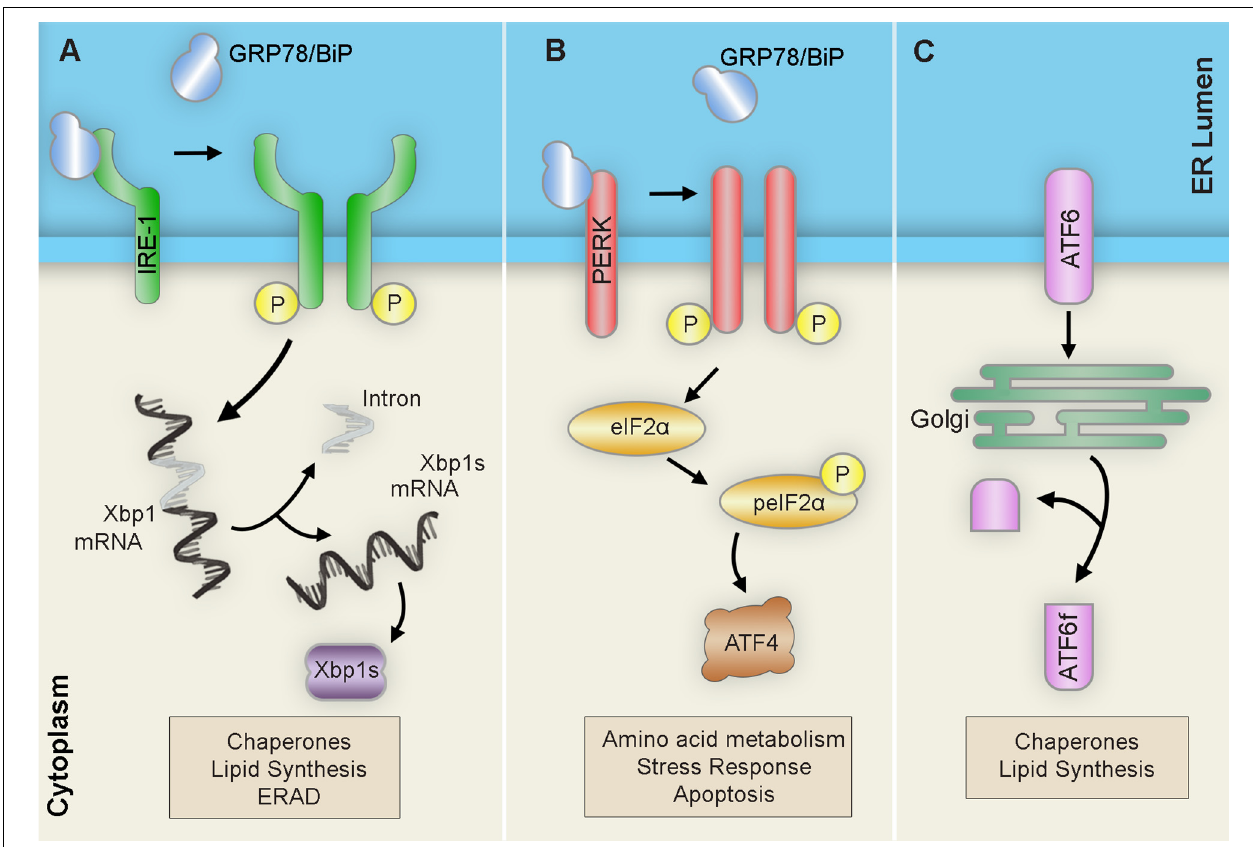
FIGURE 2 | Unfolded protein response (UPR) pathways. Upon ER stress, the ER launches three pathways collectively known as the unfolded protein response (UPR) in an attempt to restore proteostasis: (A) IRE1 homodimerizes and autophosphorylates to promote the alternative splicing of Xbp1 mRNA into the Xbp1 spliced form (Xbp1s) transcript. After translation, the resulting Xbp1s transcription factor translocates to the nucleus of the cell to activate ER chaperones, ERAD components, and lipid biosynthesis factors. (B) PERK homodimerizes and autophosphorylates to induce eIF-2 α phosphorylation ultimately leading to the upregulation of the transcription factor ATF4. This will result in subsequent upregulation of amino acid metabolism, stress response, and apoptosis. (C) ATF6 translocates to the Golgi where it is cleaved into its active form ATF6f and then moves to the nucleus to trigger the expression of ER chaperones, XBP-1, CHOP, and members of the ER-associated degradation (ERAD) pathway. Abbreviations: ATF, activating transcription factor; ATF6f, activating transcription factor 6 fragment; CHOP, C/EBP-homologous protein; eIF-2 α , eukaryotic translation initiation factor 2 α ; ERAD, ER-associated degradation; IRE1, inositol requiring transmembrane kinase/endonuclease-1; P, phosphate; PERK, PKR-like ER kinase; XBP-1 unspliced, X-box binding protein 1; XBP1s, XBP-1